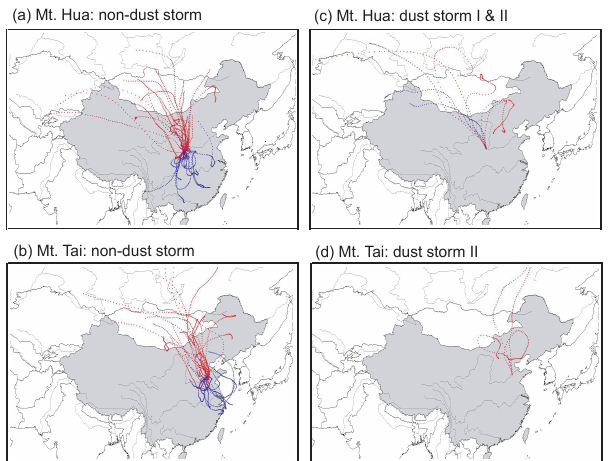
at (a) Mt. Hua and (b) Mt. Tai during non-duststorm days